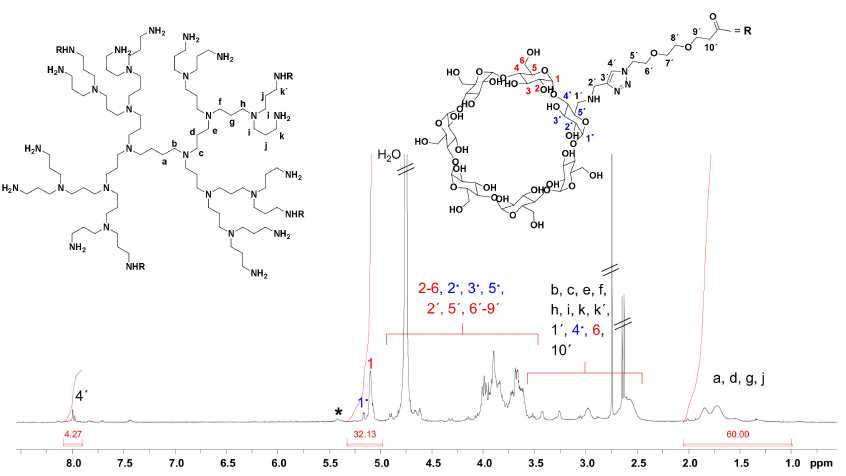
Figure A4. 1 H NMR spectrum of CD-PPI (G2) in D 2 O. * unknown 1 H NMR signal next to anomeric protons (1 and 1.) of β CD